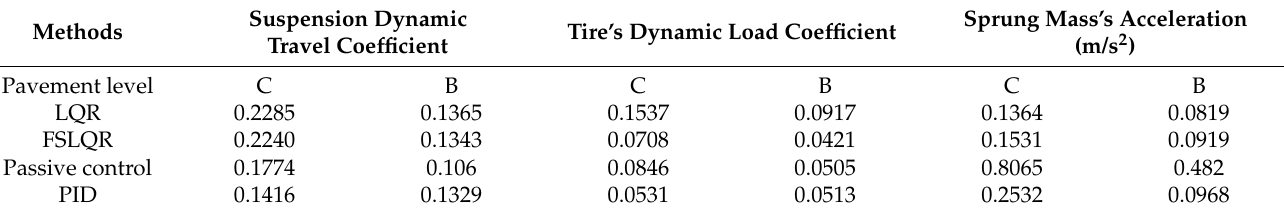
Figure 9. The sprung mass’s acceleration responses under random excitation, ( a ) under the national standard C-grade road surface, ( b ) under the national standard B-grade road surface. Table 3. The root mean square value of the random excitation